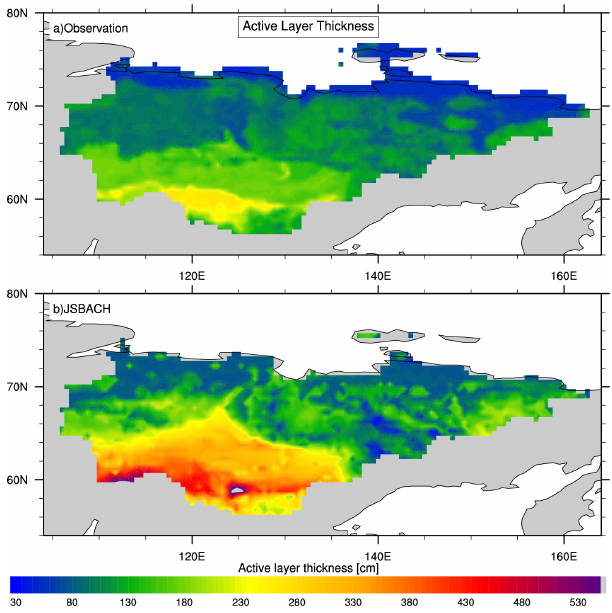
Fig. 13. Observed (map a ; see text for more details) (Beer et al., 2013) and simulated active-layer thickness (map b ) in the Yakutsk